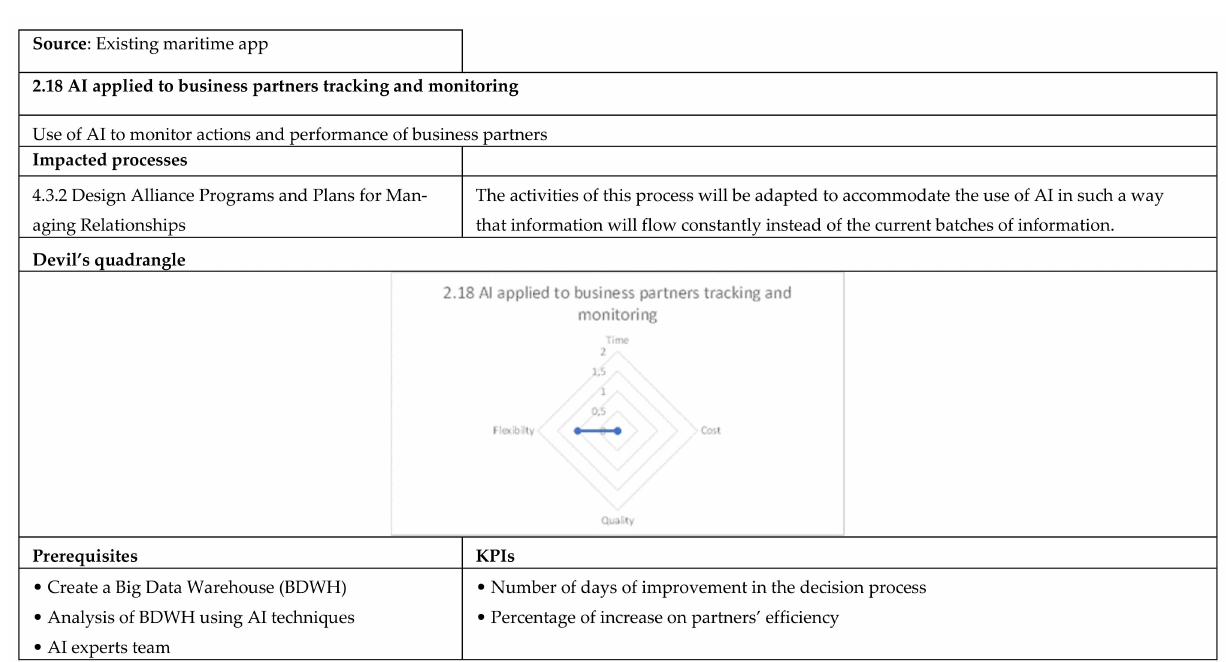
Figure A21. AI applied to competitors tracking and monitoring data sheet.